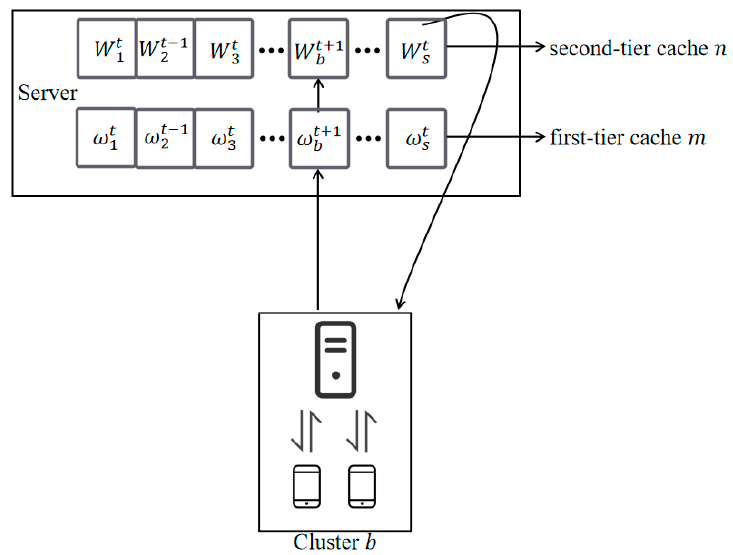
Figure 3. Update principle of the second-tier cache. The second-tier cache sends the model to cluster 𝑏 using a random distribution.